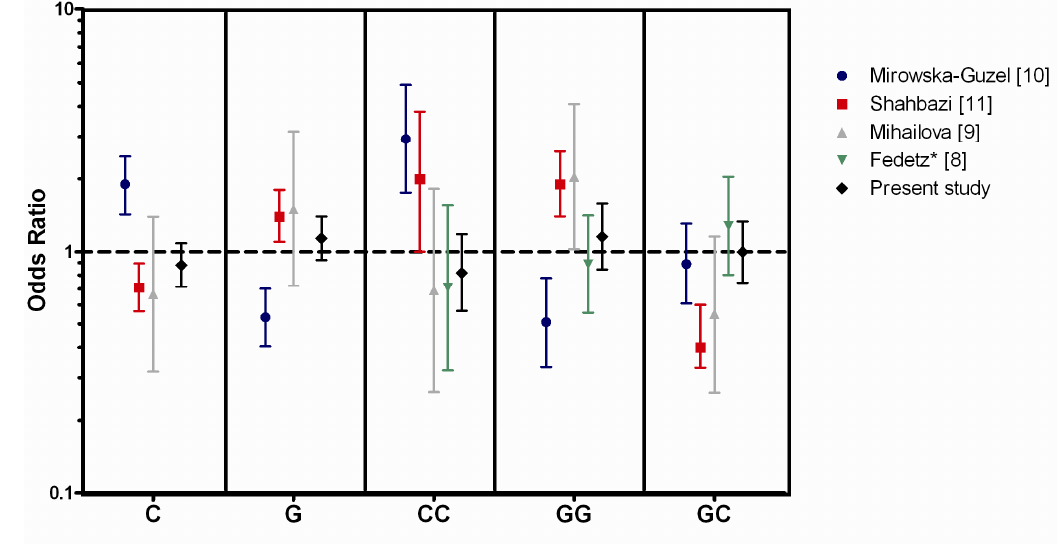
Figure 1. Meta analysis of the odds ratios in the five studies that have investigated − 174 IL6 promoter region polymorphisms in MS. * This study inferred the − 174 genotypes from the − 597